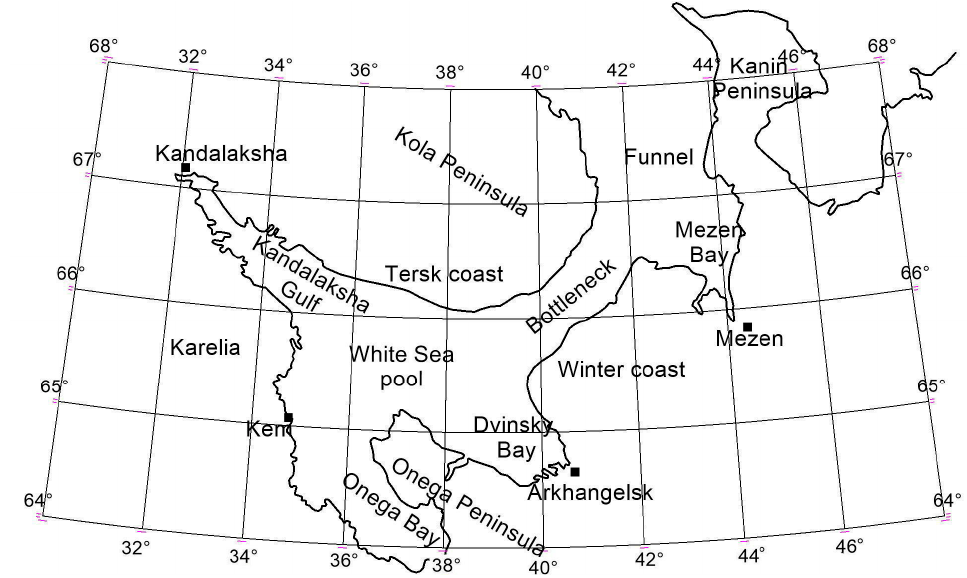
Figure 1. Main structural elements of the White Sea region.